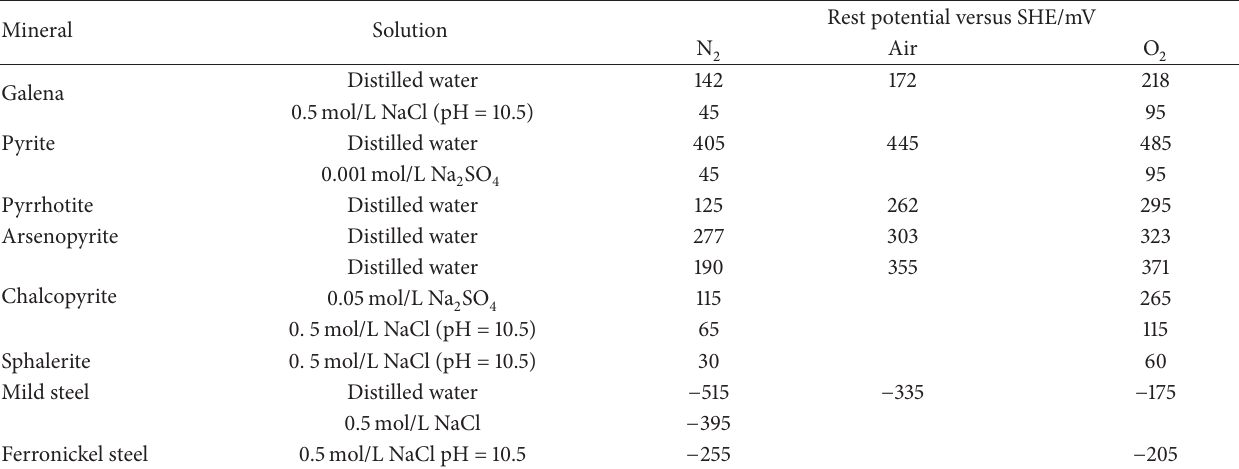
Table 4: Rest potential of sulphide minerals and steel media at near neutral pH [7,